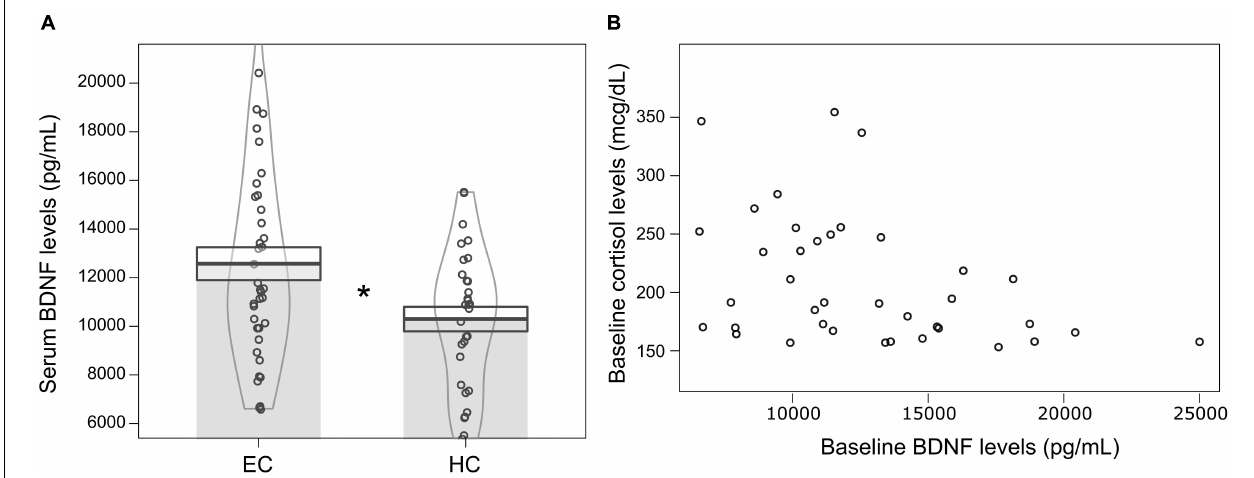
FIGURE 3 | (A) Mean ± standard error of serum BDNF levels (pg/mL) at baseline for volunteers with hypocortisolemia (HC, n = 31) (serum cortisol < 15 mcg/dL) and eucortisolemia (EC, n = 38) (15 mcg/dL < serum cortisol < 43 mcg/dL). Independent Student T -test, ∗ p ≤ 0.05, statistically significant difference between-groups. The curvilinear gray lines represent the density of samples distribution. The circles represent individuals in each group. (B) Significant negative correlation between serum BDNF and serum cortisol levels for eucortisolemic volunteers (MD and CG) at baseline ( N = 38; Spearman test, p < 0.05, rho = –0.39).